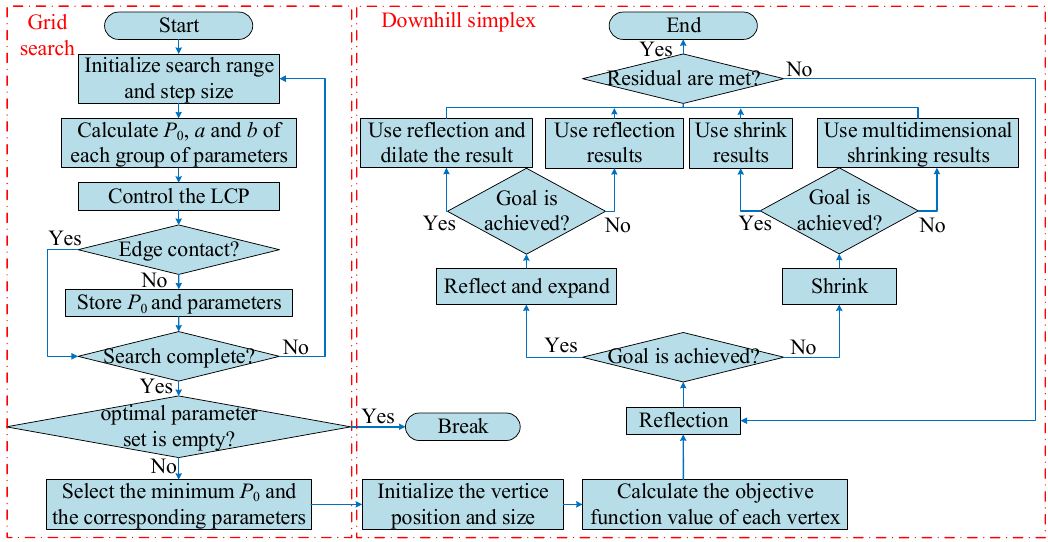
Figure 10. Flow chart of the optimization algorithm. Step 1 is to initialize the search range and the step size in grid searching. The search range of the parabolic offset distance is set as u 0 ∈ [ − 1, 2], and the step size is 0.1. The search range of the parabolic coefficient is set as a r ∈ [ − 0.01, 0.01], and the step size is